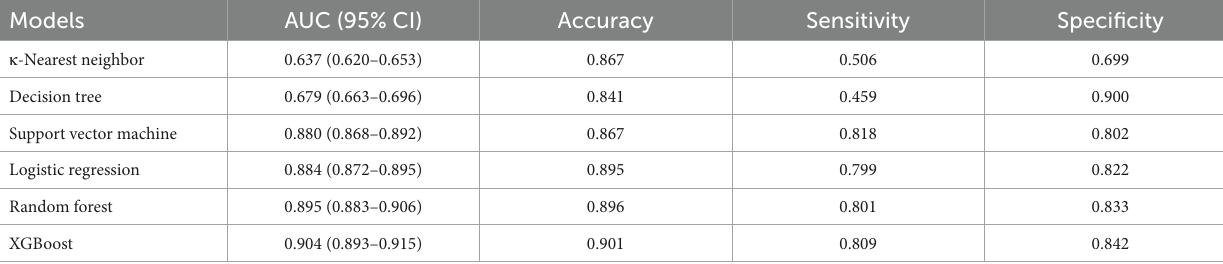
TABLE 2 The evaluation of the six ML models predictive